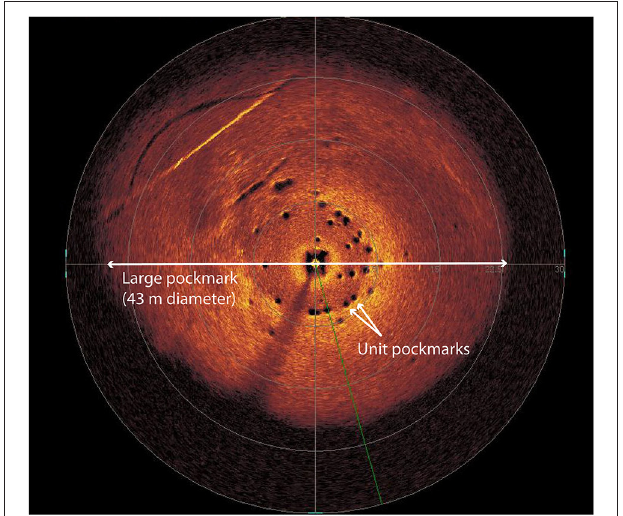
FIGURE 6 | Sonar picture of the largest pockmark at TPS comprising several unit pockmarks of 0.3 to 0.8m diameter.